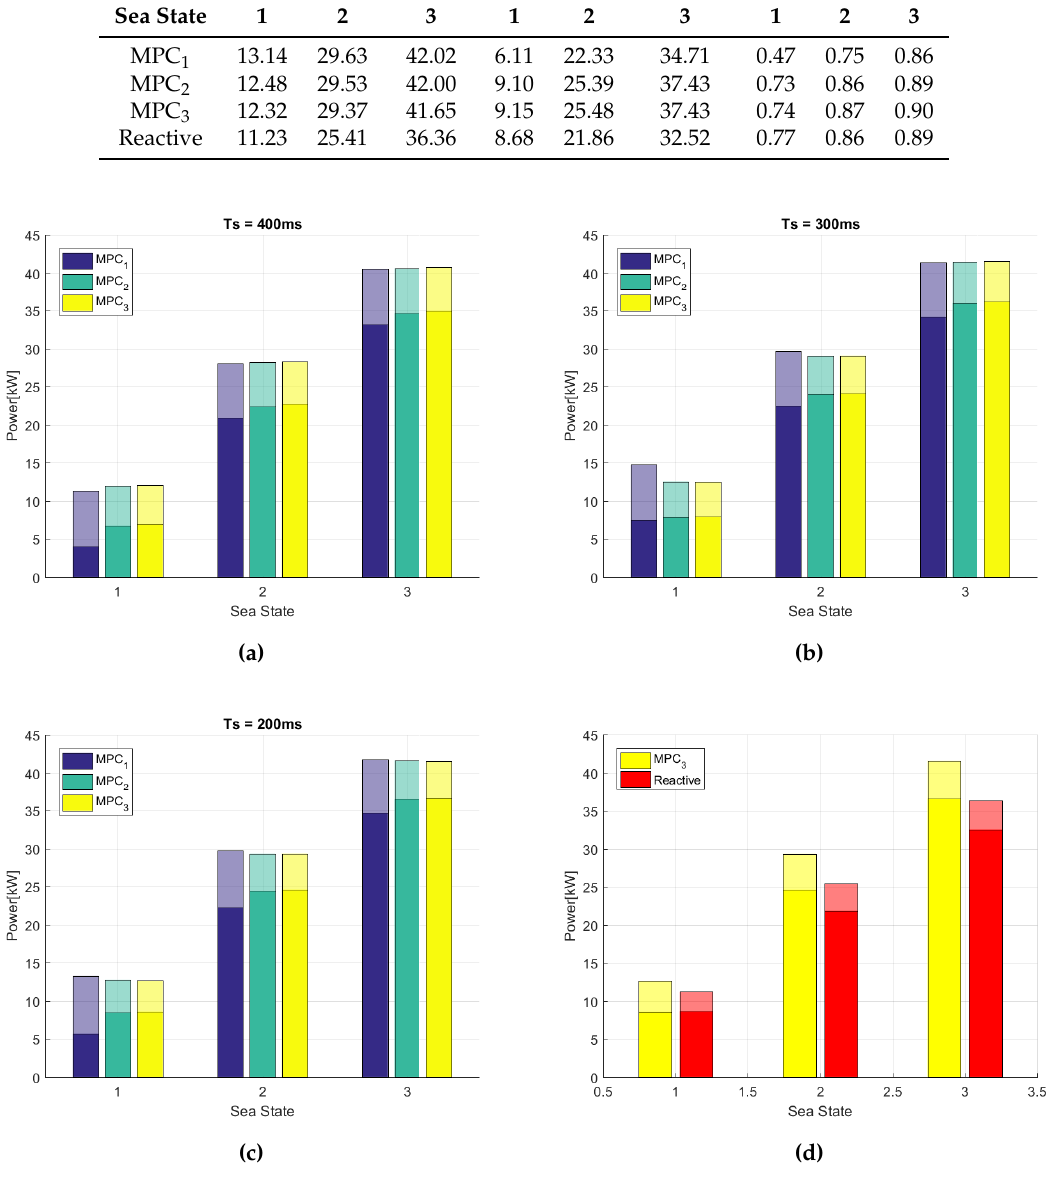
Figure 12. Average absorbed and harvested power versus sea states using different controllers. (a): T s